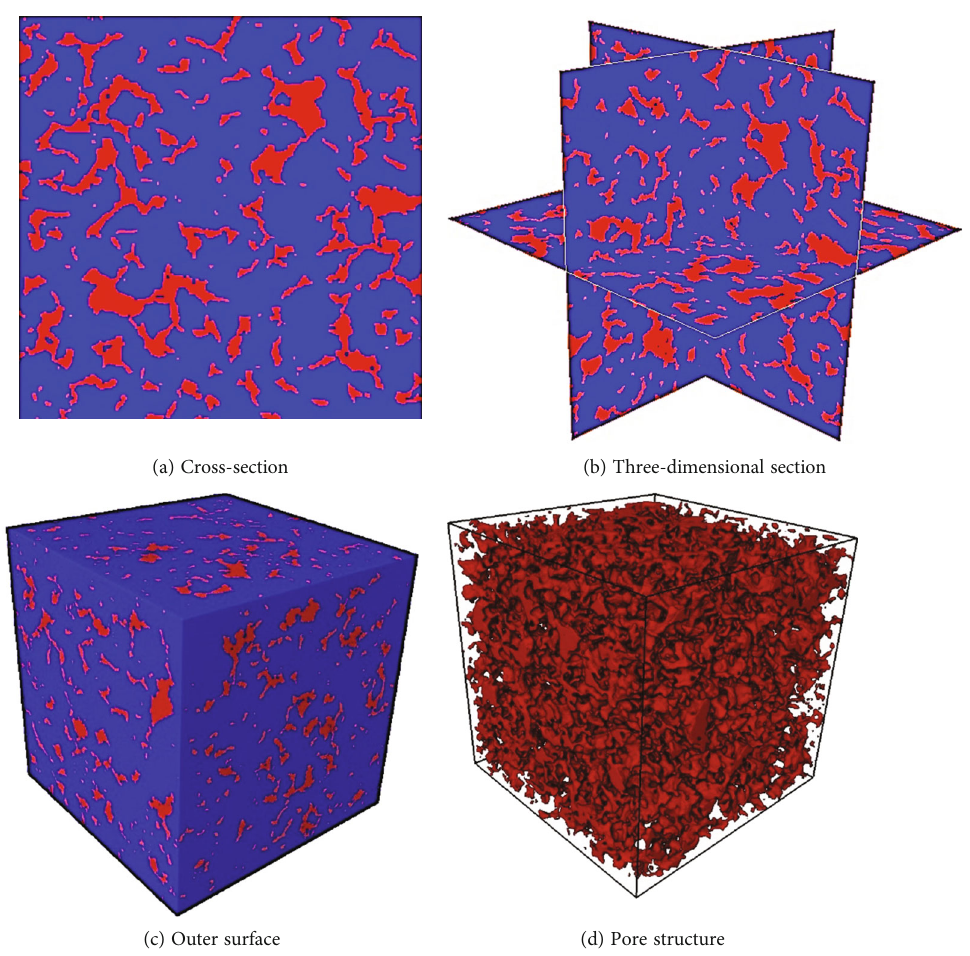
Figure 5: Digital core modeling based on pretrained discriminator. Table 2: Comparison of parameters between real core sample and generated core